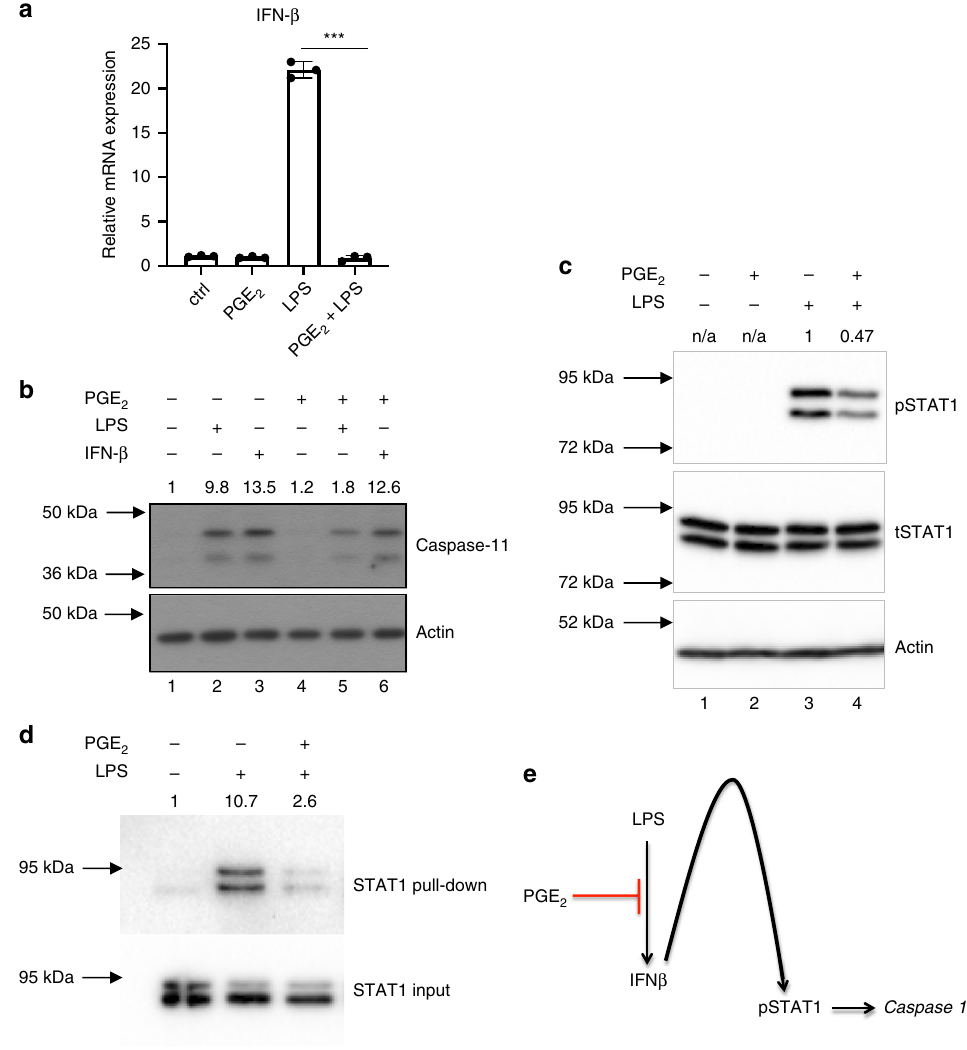
Fig. 2 Prostaglandin E 2 inhibits caspase-11 expression by inhibition of IFN- β production. a BMDMs were treated with 1 μ M PGE 2 or DMSO for 30 min followed by 100 ng/ml LPS for 4h, and subjected to qPCR analysis for IFN- β . Data from BMDMs from three mice are shown, and are representative of three independent experiments, each involving three mice, with individual data points on the graph, which are means from technical duplicates. *** P <0.0001, two- tailed Student ’ s t test, error bars represent mean±SD. b BMDMs were treated with 1 μ M PGE 2 for 30 min followed by 100 ng/ml of LPS or IFN- β for 4 h, and assessed for caspase-11 by western blotting. The results shown are representative of three independent experiments. c BMDMs were treated with 1 μ M PGE 2 for 30 min followed by 100ng/ml of LPS for 2h, and assessed for phosphor-STAT-1 by western blotting. The results shown are representative of three independent experiments. d BMDMs were treated with 1 μ M PGE 2 or DMSO for 30min followed by 100ng/ml of LPS for 2h. An oligonucleotide pulldown using the caspase-11 promoter was then carried out with samples and then immunoblotted for STAT-1. The results shown are from a single experiment. Densitometry values are shown above each blot. e Schematic representation of PGE 2 -mediated inhibition of caspase-11